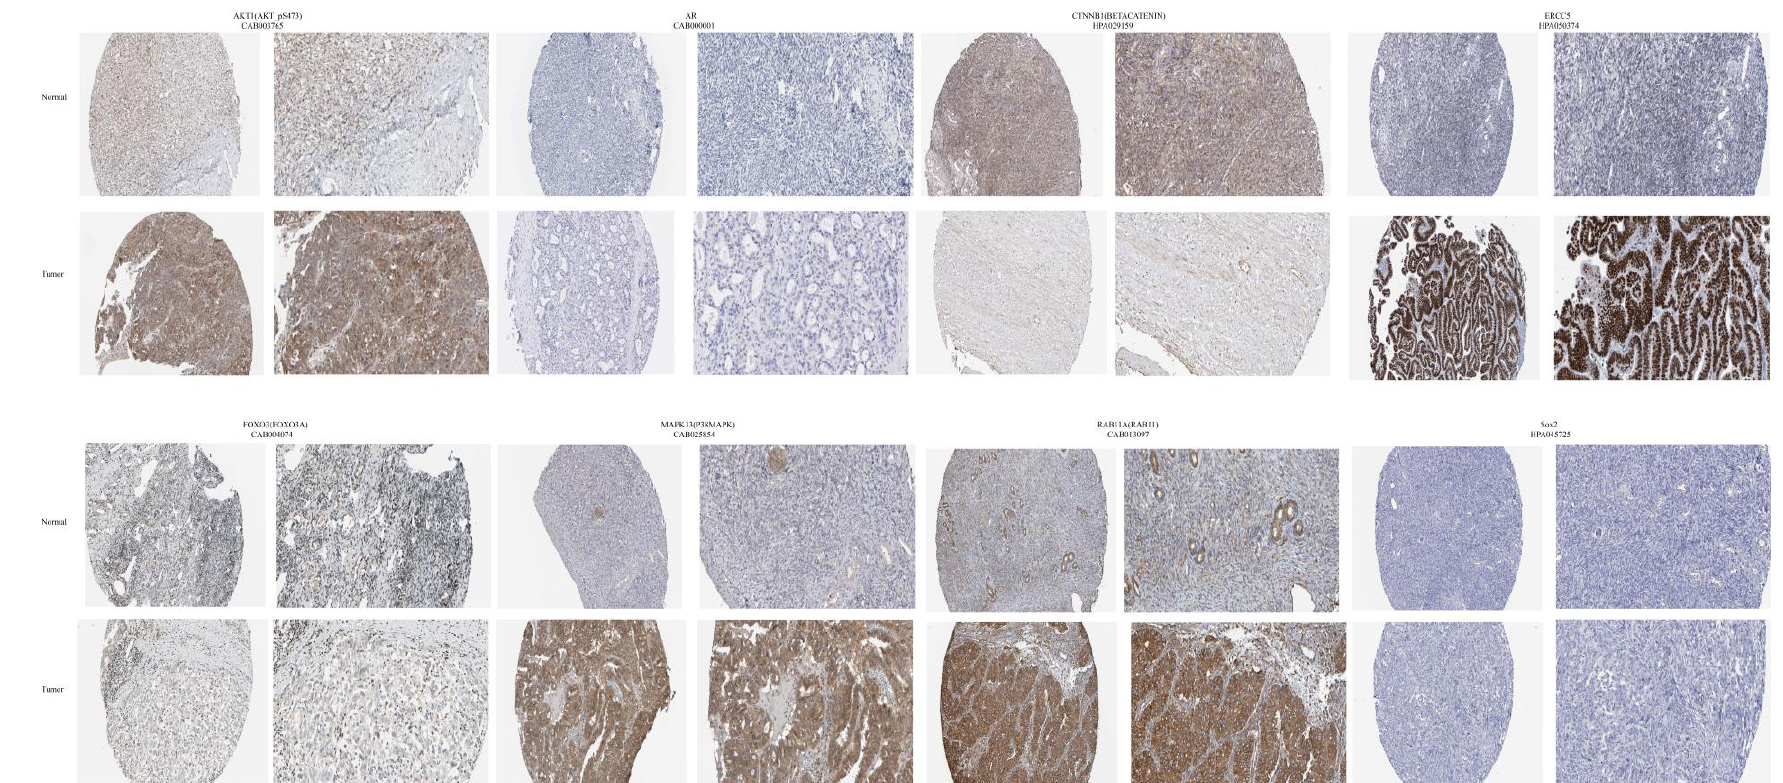
Figure 10. Expression of prognosis-related protein in ovarian cancer and normal tissues in HPA database.